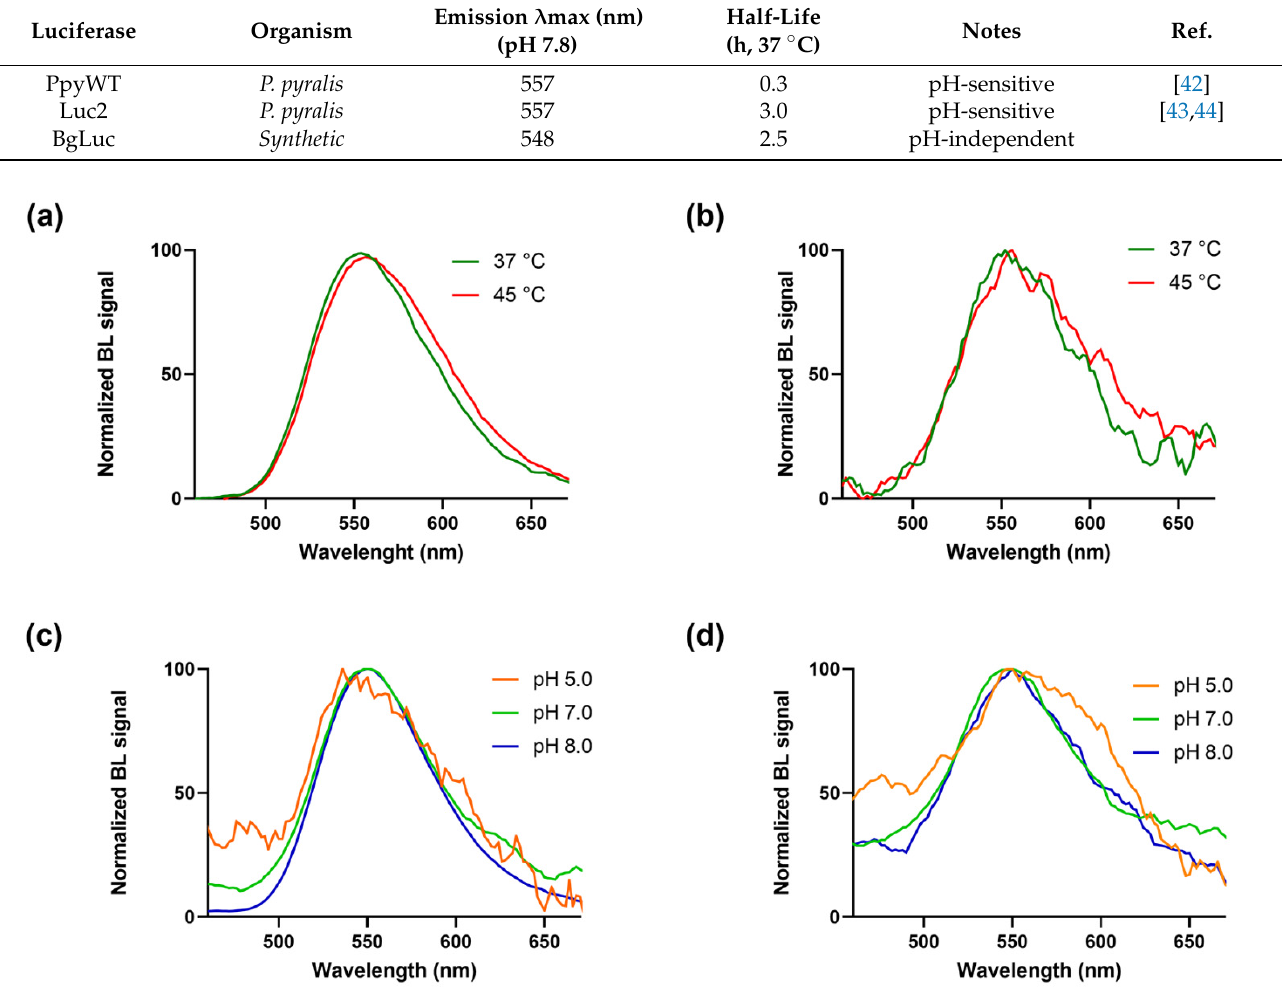
Figure 3. BgLuc mutant emission spectra were obtained at different temperatures with the ( a ) BrightGlo and ( b ) D-Luciferin 1.0 mM substrates and at different pH with the ( c ) BrightGlo and ( d ) D-Luciferin 1.0 mM